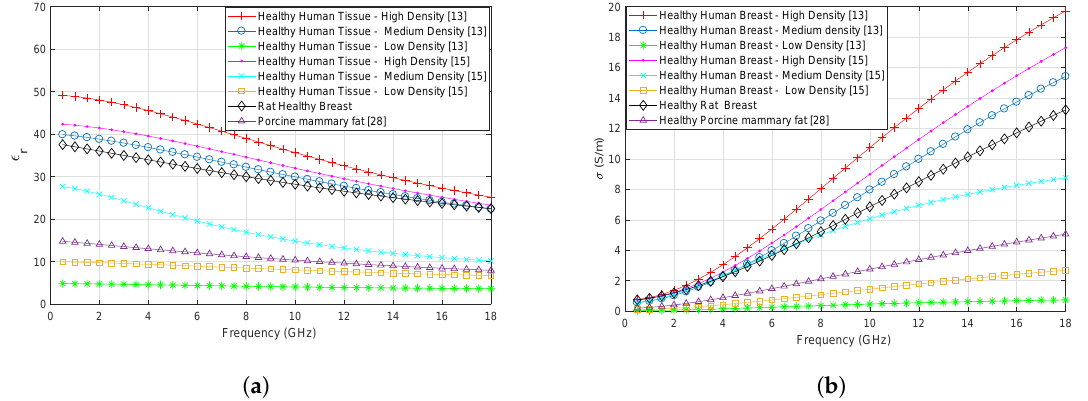
Figure 6. Dielectric property comparisons of ex vivo healthy human breast tissues and porcine mammary tissues with high, median, low density and healthy in vivo rat breast tissues: ( a ) Relative permittivity values; ( b ) Conductivity values.